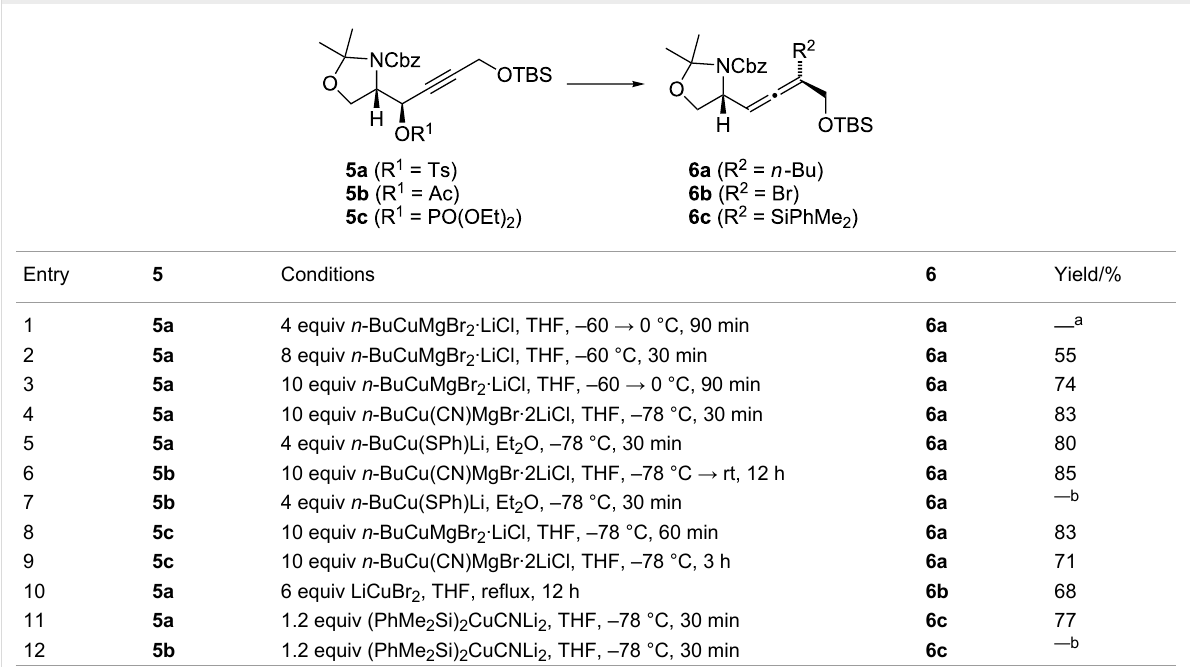
Table 1: Copper-promoted S N 2’-substitution of propargylic electrophiles 5 to afford allenes 6